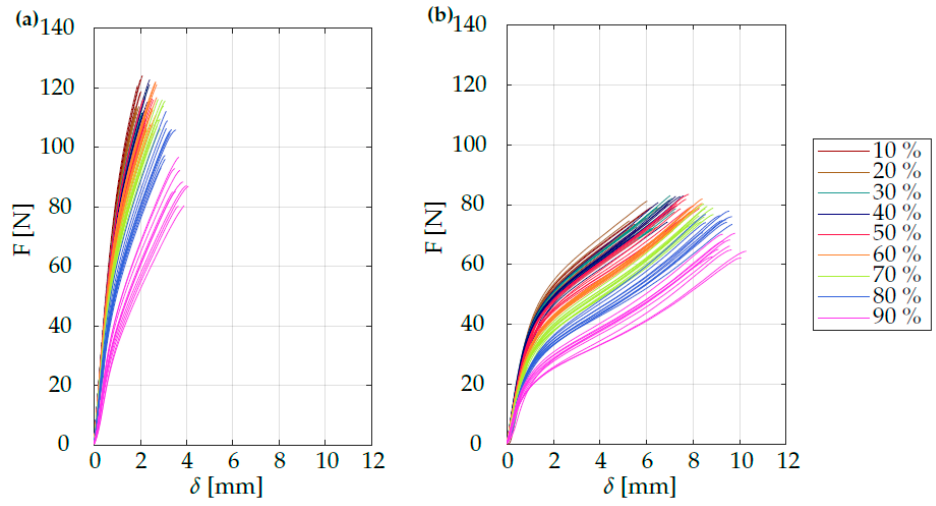
Figure 5. Tensile stiffness of bleached Kraft paper at different relative humidity in MD ( a ) and CD ( b ).